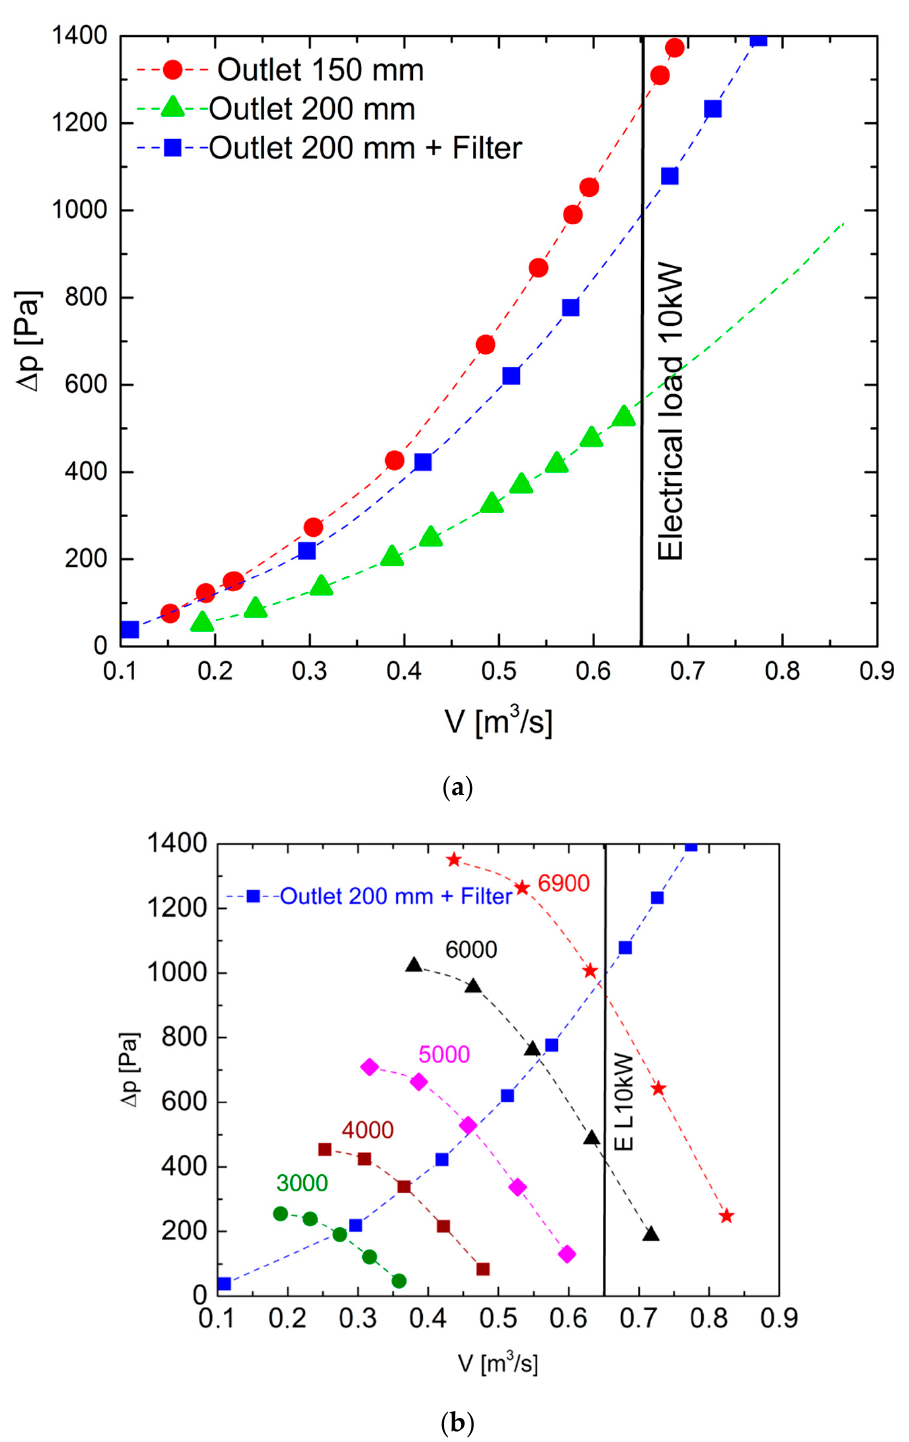
Figure 15. ( a ) Total pressure losses ( ∆ p) vs. volumetric flow rate determined for a cooling system integrated with a V-type PEMFC stack. ( b ) Total pressure losses ( ∆ p) vs. volumetric flow rate determined for a cooling system integrated with a V-type PEMFC stack. Data for different rotor speeds (1/min): dotted line—data from a numerical simulation; figures and symbols—data from experimental measurements.